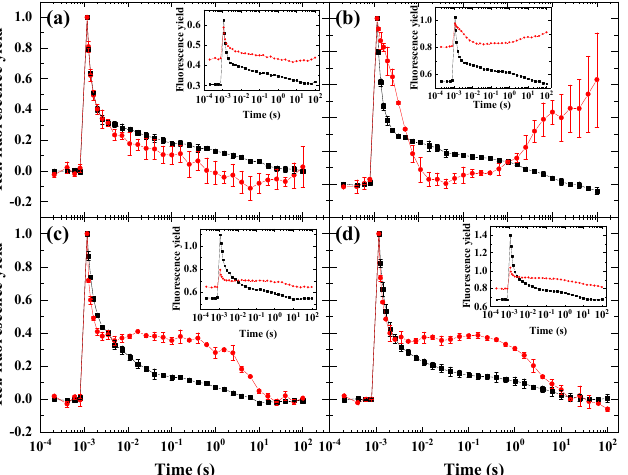
Figure 3. Flash-induced fluorescence relaxation in control aerobic condition (black) and in the presence of 1 mM hydroxylamine (HA) + microaerobic condition (red). ( a ) Haematococcus pluvialis (green cells), ( b ) Dunaliella salina , ( c ) Chlorella sorokiniana , ( d ) Nannochloropsis limnetica . Curves were normalized (F 0 to 0 and F m(ST) , which represents maximal fluorescence after the flash to 1) to achieve the same initial amplitudes. The insets show the original curves, averaged over the three biological replicates, without normalization. Error bars represent the standard deviation of the mean of three biological replicates.